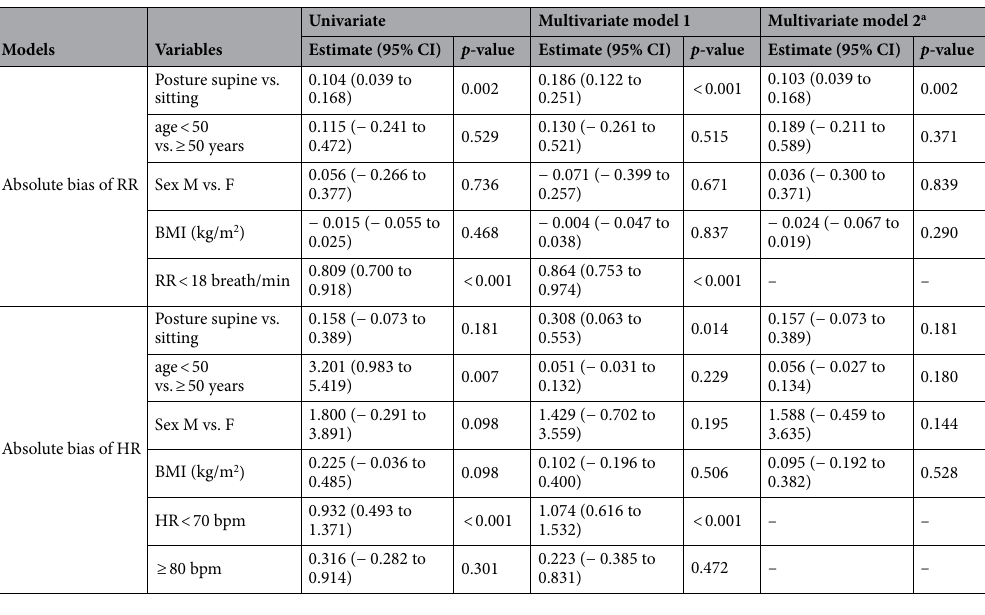
Table 3. Determinants of the absolute bias levels. Linear mixed effect models were performed with individuals as the random term were used to estimate the effects of the factors. BMI body mass index, M male, F female, HR heart rate, RR respiratory rate. a Multivariate model 2 = multivariate model 1 minus RR (or